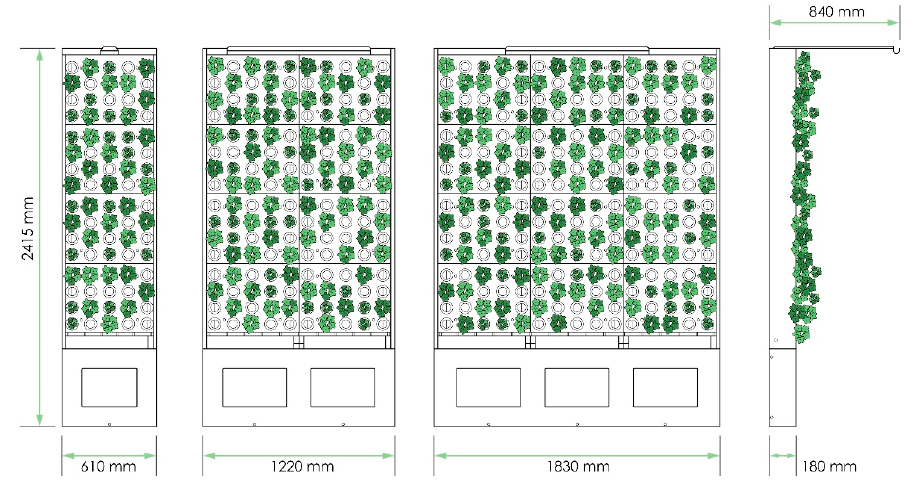
Figure 11. Living wall with Biotile component based on [38].